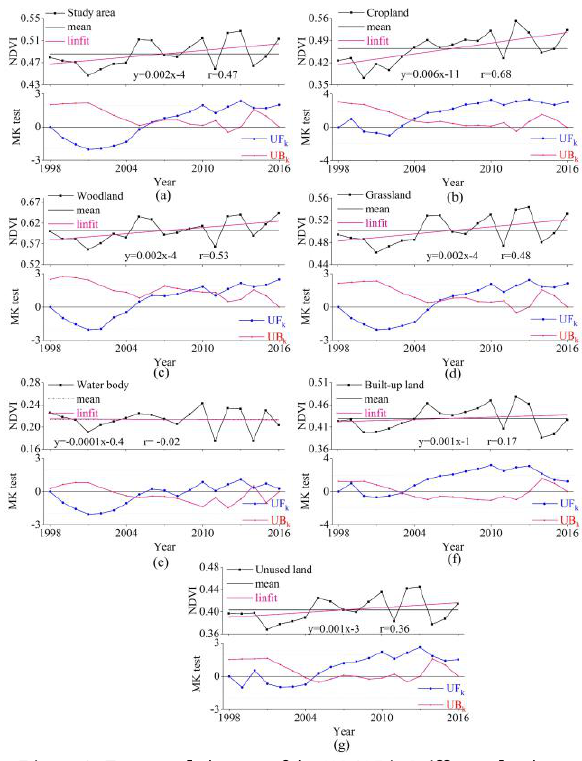
Figure 3. Temporal change of the NDVI in Different land use types: (a) the Yellow River source region; (b) cropland; (c) woodland; (d) grassland; (e) water body; (f) built-up land; (g) unused land. Figure 2. (a)Spatial distribution of the mean NDVI in region from 1998 to 2016; (b)Spatial distribution of the change trend for NDVI in region from 1998 to 2016; (c) Land use types in region in 2015.